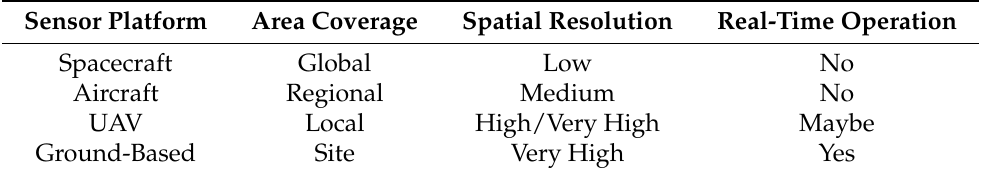
Table 4. Overview of sensor platform types. This table was adapted from [1].